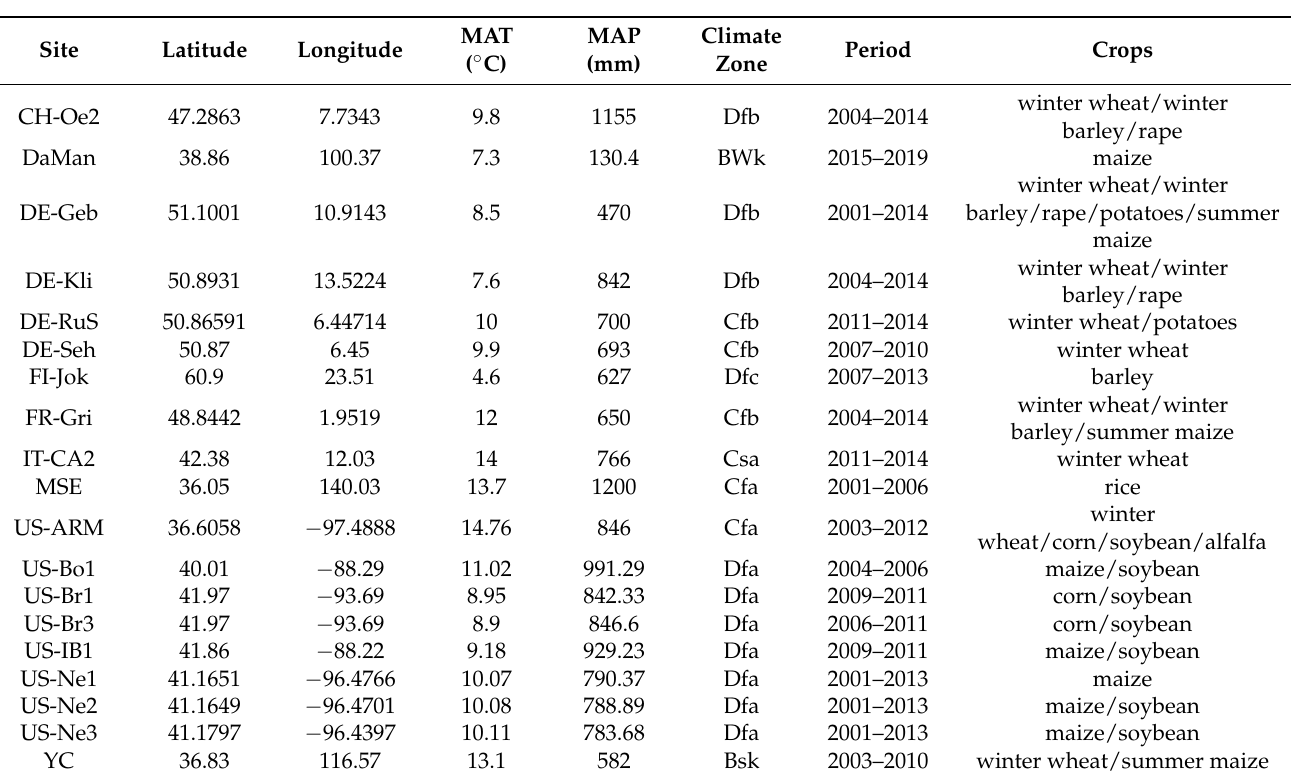
Table 2. Information of the cropland flux tower sites from which flux measurements by eddy covari- ance system were collected and used in this study. Climate zone codes were adopted from [56] and given in Table A1 of Appendix A. MAT: mean annual temperature; MAP: mean annual